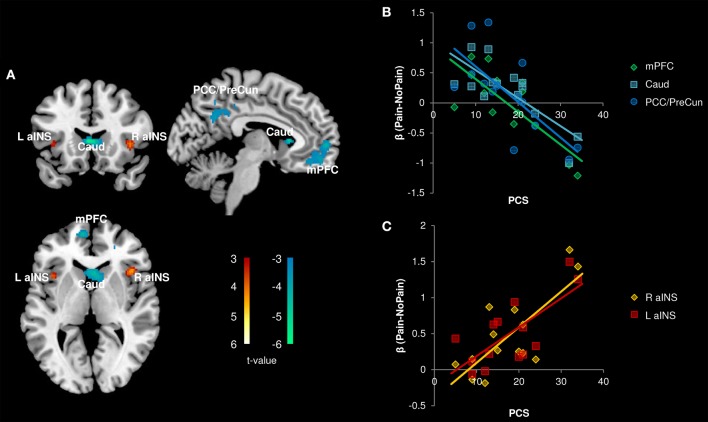
Correlation with Pain Catastrophizing Scale (PCS) scores (n = 14). (A) Whole brain correlations conducted on the [Pain (P1+P2) > No Pain (P0)] contrast, p < 0.005, cluster-level correction p < 0.05. Insula clusters displayed at puncorrected < 0.005. (B) Extracted activity from caudate (Caud), medial prefrontal cortex (mPFC), and posterior cingulate cortex/precuneus (PCC/PreCun) clusters plotted against PCS scores. (C) Extracted activity from left anterior insula (L aINS) and right anterior insula (R aINS) clusters plotted against PCS scores. Warm colors, positive correlation; Cool colors, negative correlation.